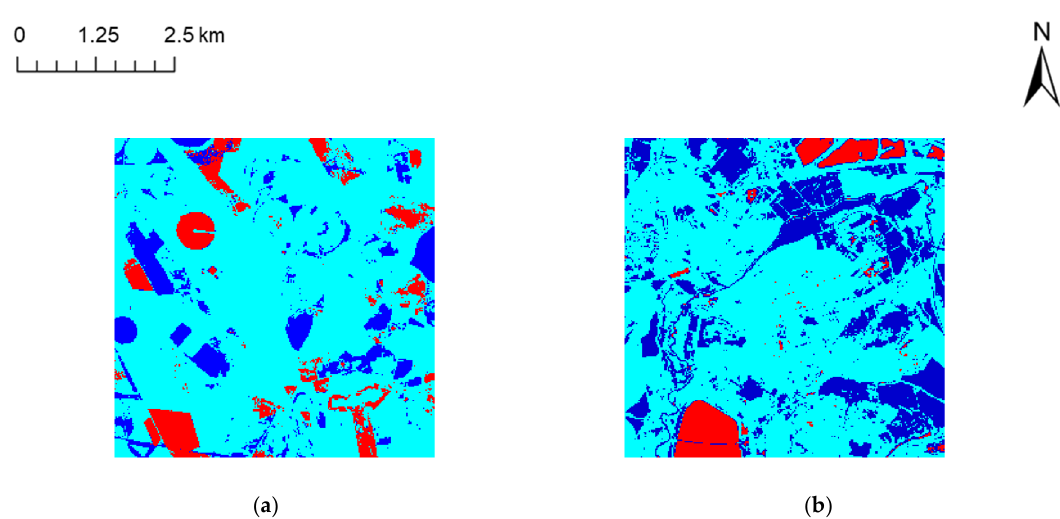
Figure A2. Quality flag layer for the Las Tiesas–Barrax ( a ) and Wytham Woods ( b ) high-spatial-resolution reference maps. The red, light blue, and dark blue pixels indicate low-, good-, and high-confidence, respectively. For low-confidence pixels, the transfer function is acting as an extrapolator.